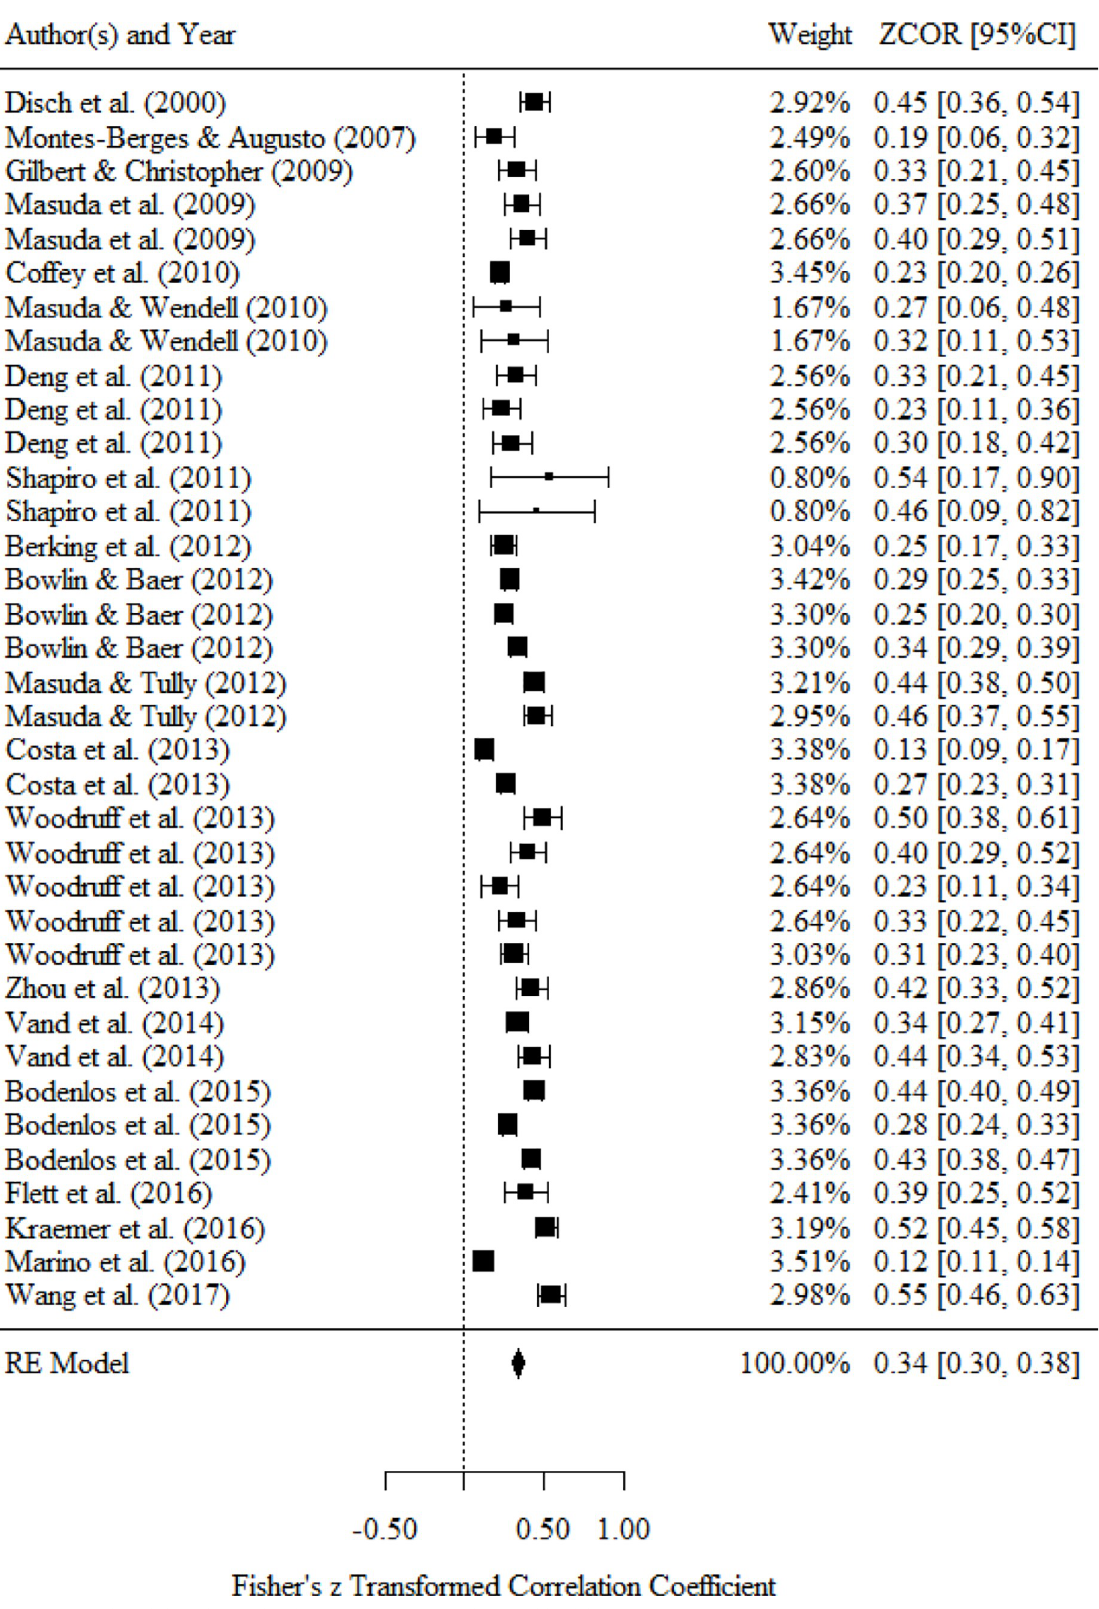
Fig 2. Forest plot of the relationship between attention and mental health. https://doi.org/10.1371/journal.pone.0223310.g002 PLOS ONE | https://doi.org/10.1371/journal.pone.0223310 September 27,